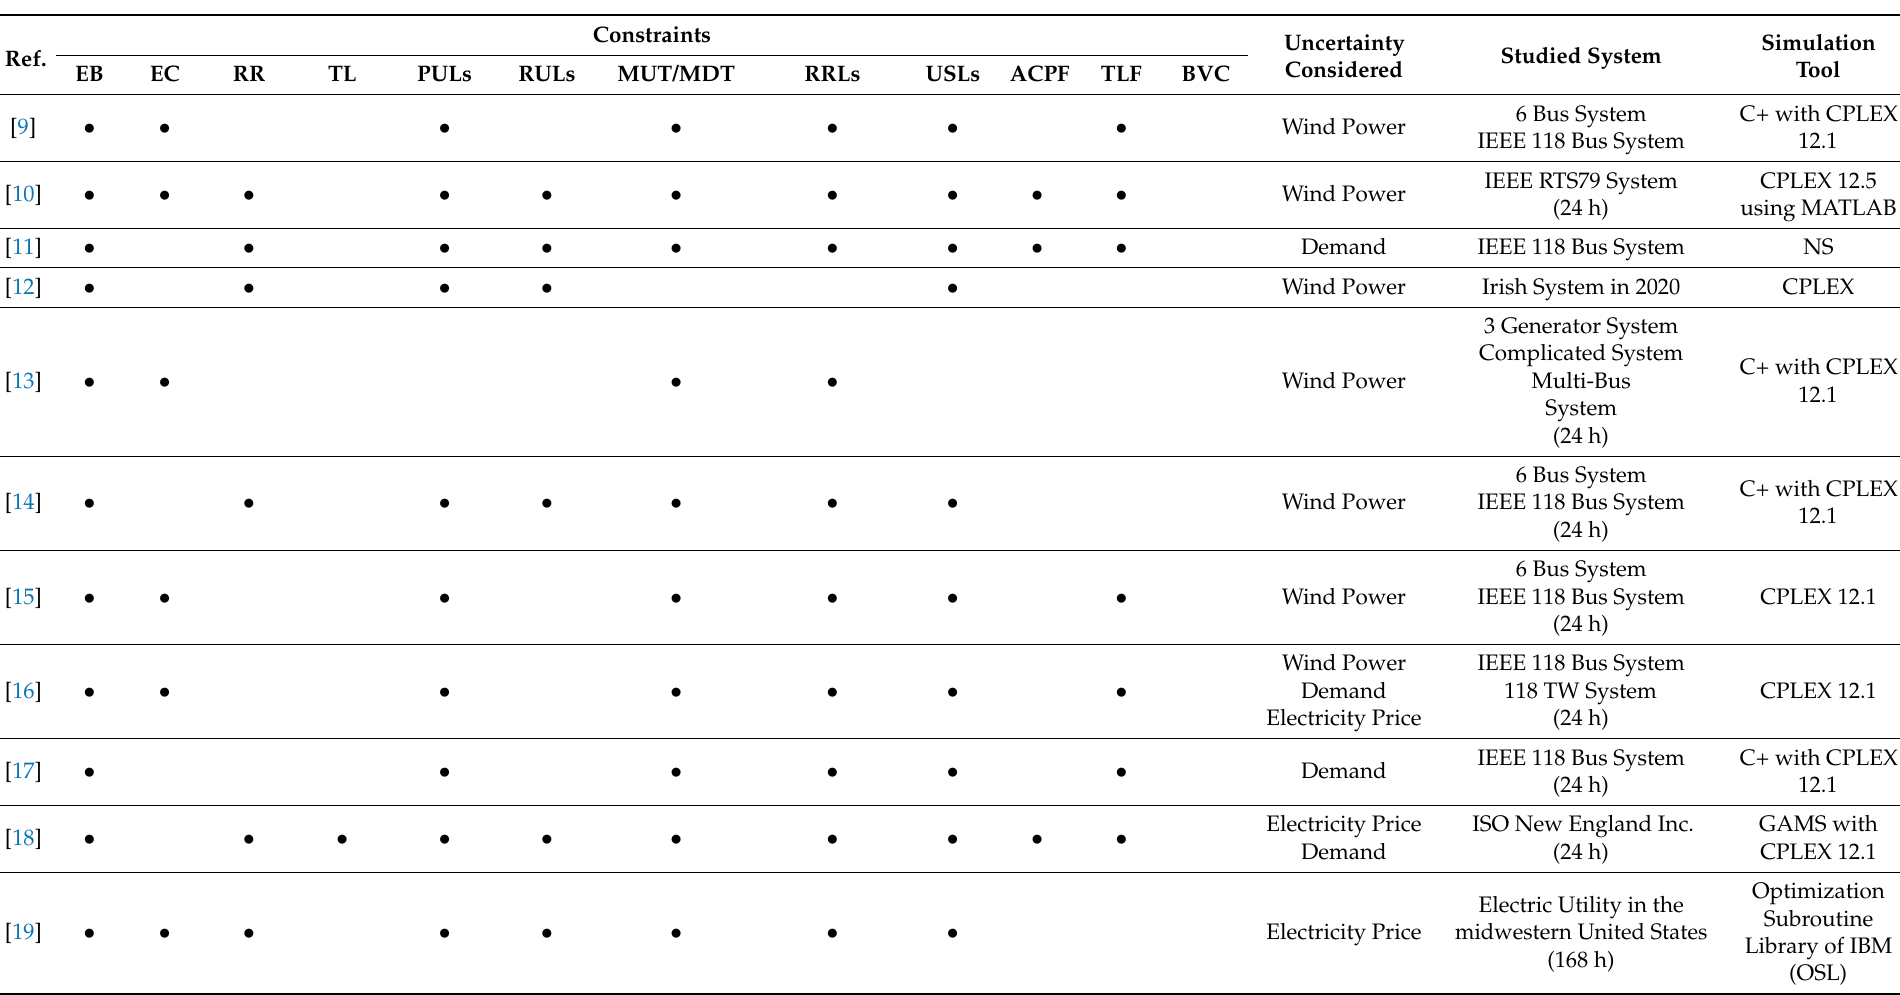
Table 17. Methods For UCP With Uncertainty